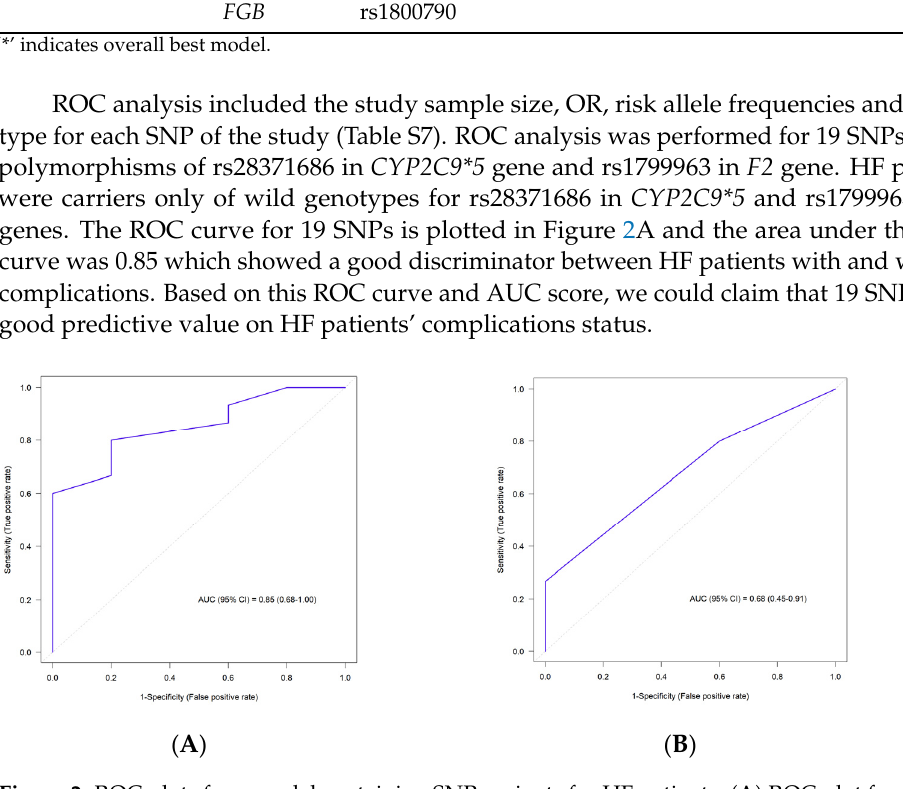
Figure 2. ROC plots for a model containing SNP variants for HF patients. ( A ) ROC plot for a model containing 19 SNP variants for HF patients (AUC = 0.85). ( B ) ROC plot for a containing 19 SNP variants for HF patients (AUC = 0.85). ( B ) ROC plot for a model containing 4 SNP model containing 4 SNP variants for HF patients (AUC = 0.68). variants for HF patients (AUC =